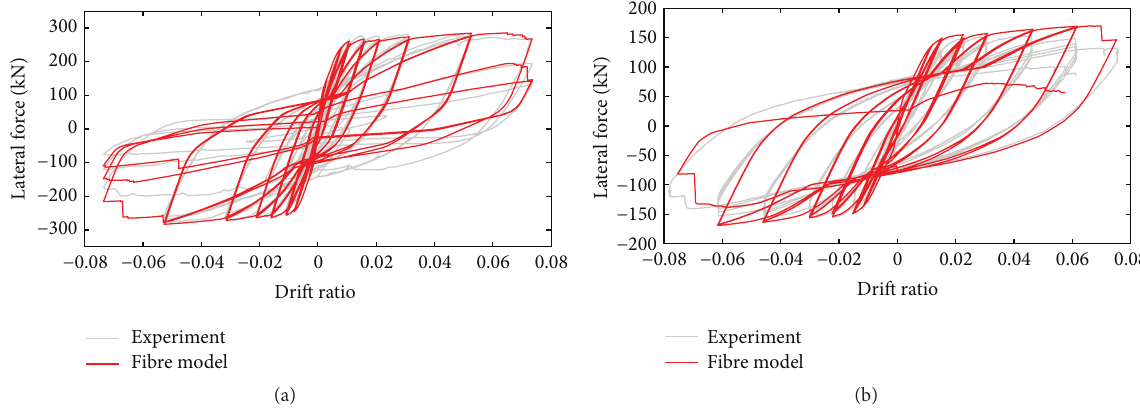
Figure 8: Comparison of experimental results and calibrated numerical model of uncorroded columns: (a) Lehman’s column 415; (b) Moyer and Kowalsky’s column